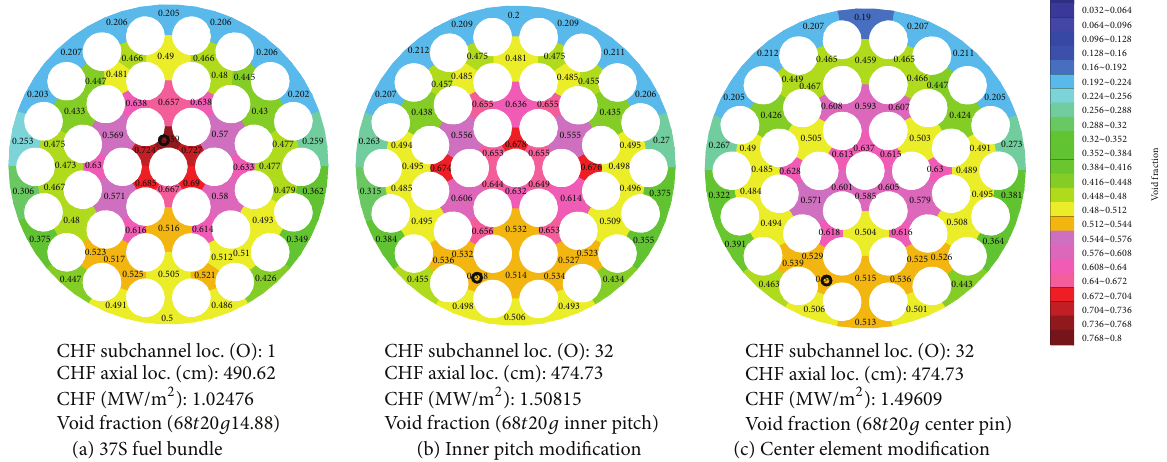
Figure 11: Void fraction distributions of the standard 37-element fuel and its modifications at 268 ∘